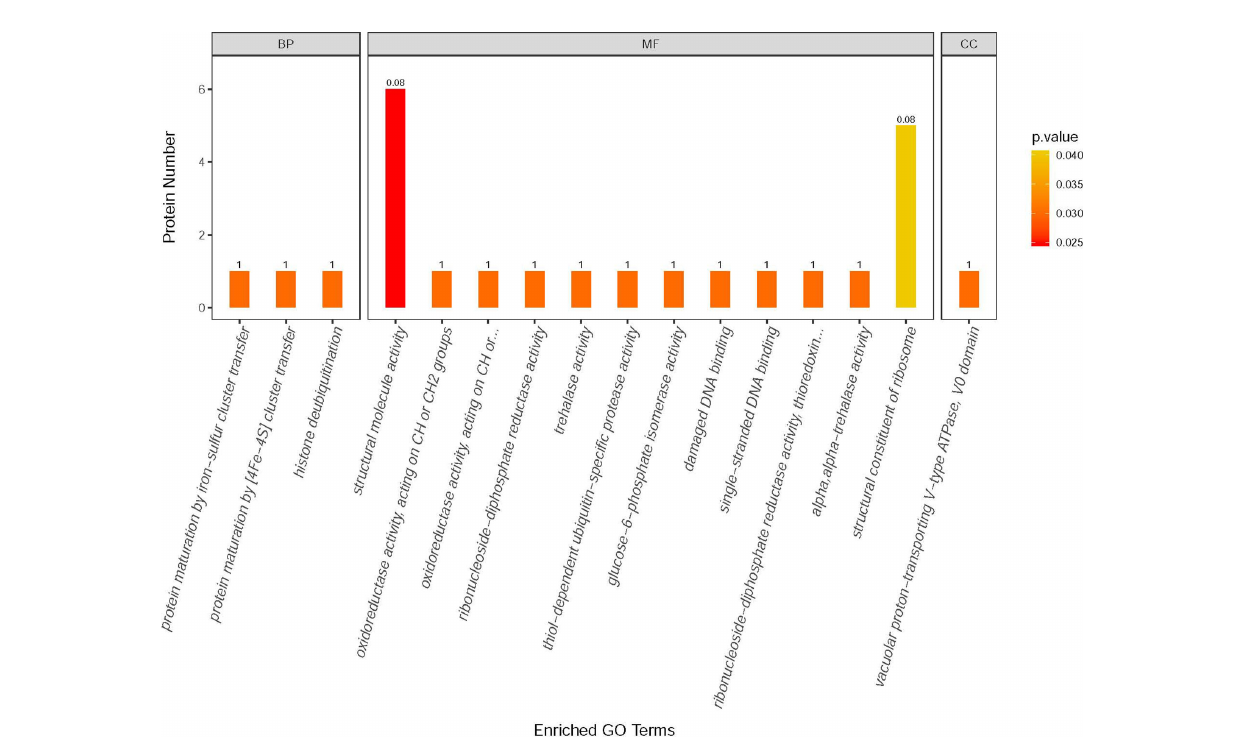
FIGURE 6 | GO annotation and enrichment analysis of differentially expressed proteins in E. hellem post-exposure to VWF. The primary Y axis denotes the number of annotated proteins categorized to each GO term. The secondary Y axis represents the percentage of annotated proteins to each GO term in all differential proteins. GO terms are classi fi ed into three subcategories, including biological process (BP), molecular function (MF) and cellular compartment (CC). The color gradient represents the p-value; the closer to red, the smaller the p-value. The enriched proteins are categorized and showed on X axis as: 1 — Protein maturation by iron-sulfur cluster transfer; 2 — Protein maturation by [4Fe – 4S] cluster transfer; 3 — Histone deubiquitination; 4 — Structural molecule activity; 5 — Oxidoreductase activity; 6 — Oxidoreductase activity, acting on CH2 groups; 7 — Ribonucleoside-diphosphate reductase activity; 8 — Trehalase activity; 9 — Thiol-dependent ubiquitin- speci fi c protease activity; 10 — Glucose-6-phosphate isomerise activity; 11 — Damage DNA binding; 12 — Single-stranded DNA binding; 13 — Thioredoxin activity; 14 — Alpha trehalase activity; 15 — Structural constituent of ribosome; 16 — Vacuolar proton-transporting V-type